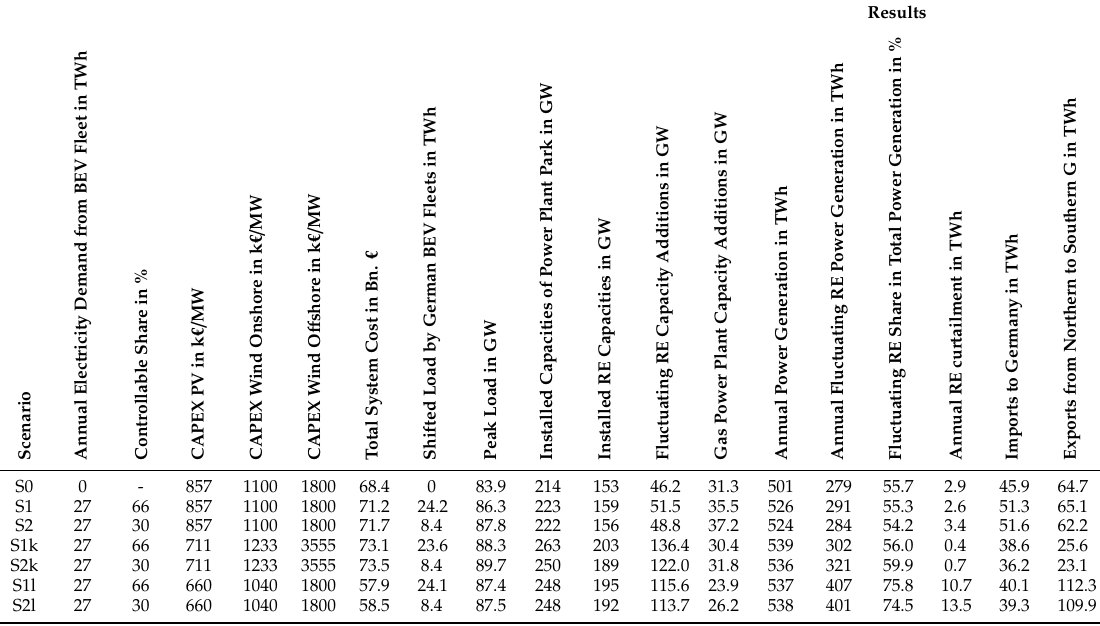
Table A10. Overview on scenario definitions and main annual results of the sensitivity analysis on specific capital expenditure assumptions for fluctuating RE technologies. Total system costs are given for the complete system boundary while all other values are given for